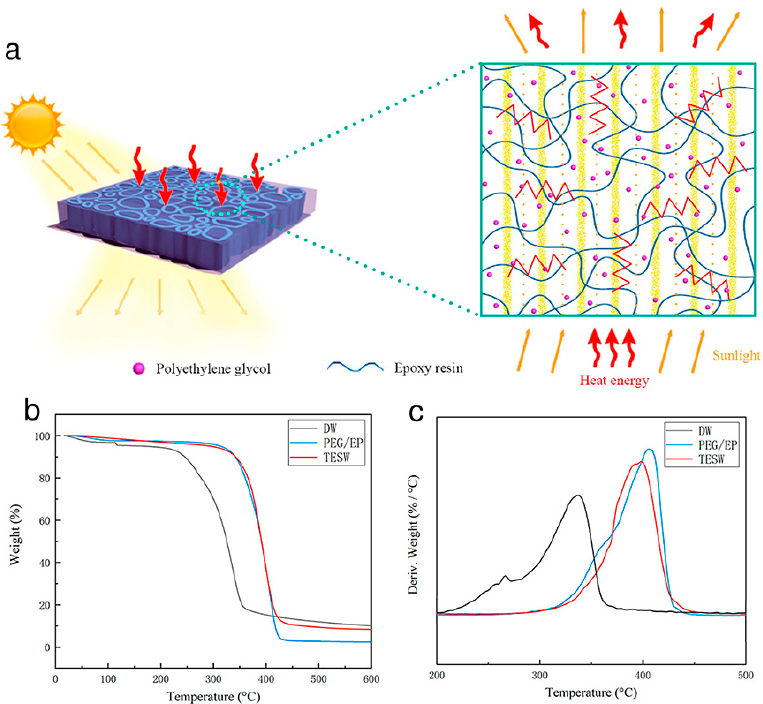
Figure 8. ( a ) Pictorial representation of optical transmission and heat conduction mechanism oc- curring in TESW composite; ( b ) thermogravimetric analysis of TESW composite and reference DW, PEG/EP PCM and ( c ) DTA curves of TESW composites and reference compounds. Abbreviations in